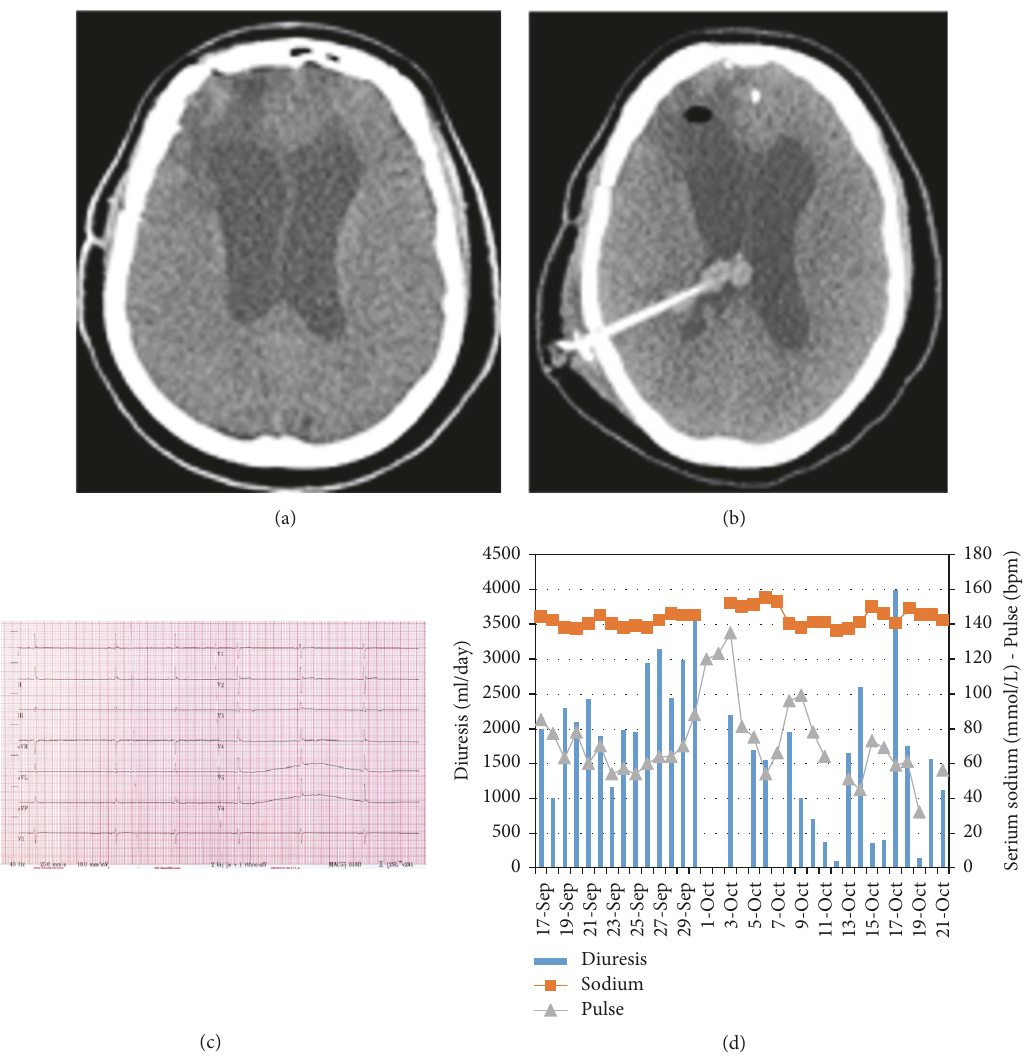
Figure 1: Oliguria during intracranial hypertension. (a) Head CT scan, during the first episode of oliguria, shows an obstructive hydrocephalus. (b) Head CT scan, during the second episode of oliguria, shows a hydrocephalus due to obstructed VP-shunt due to intraventricular bleeding. (c) ECG with sinus bradycardia (30 bpm) observed during the second episode of oliguria. (d) This graphic displays the patient’s serum sodium levels (mmol/L) in comparison with diuresis and pulse. We notice two times a significant oliguric phase on 11-Oct and 19-Oct. These were the days that intracranial hypertension was present and surgery for decompression was executed. We see a significant decrease in diuresis on 15-16-Oct; this was due to excessive high doses of desmopressin (8 𝜇 g